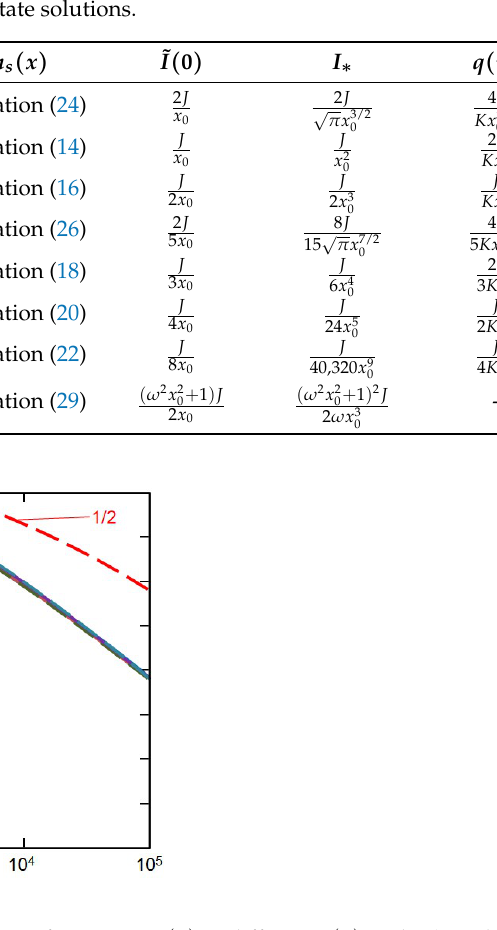
Figure 2. The steady-state density distribution functions n s ( x ) at different I ( x ) and ν (numbers at the curves) accordingly to Table 1. System parameters correspond to Figure 1 and J = 546 FI s − 1